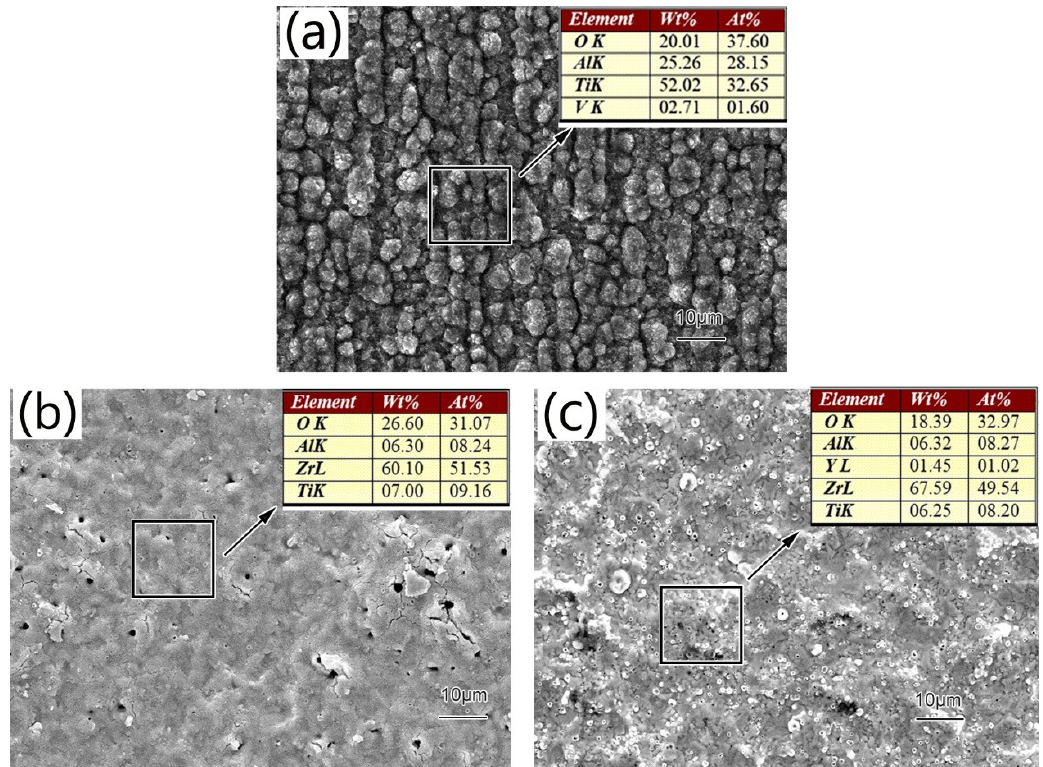
Figure 5. XRD pattern of the specimens at 750 °C for 100 h: ( a ) Zr coating; ( b ) Zr-Y coating.